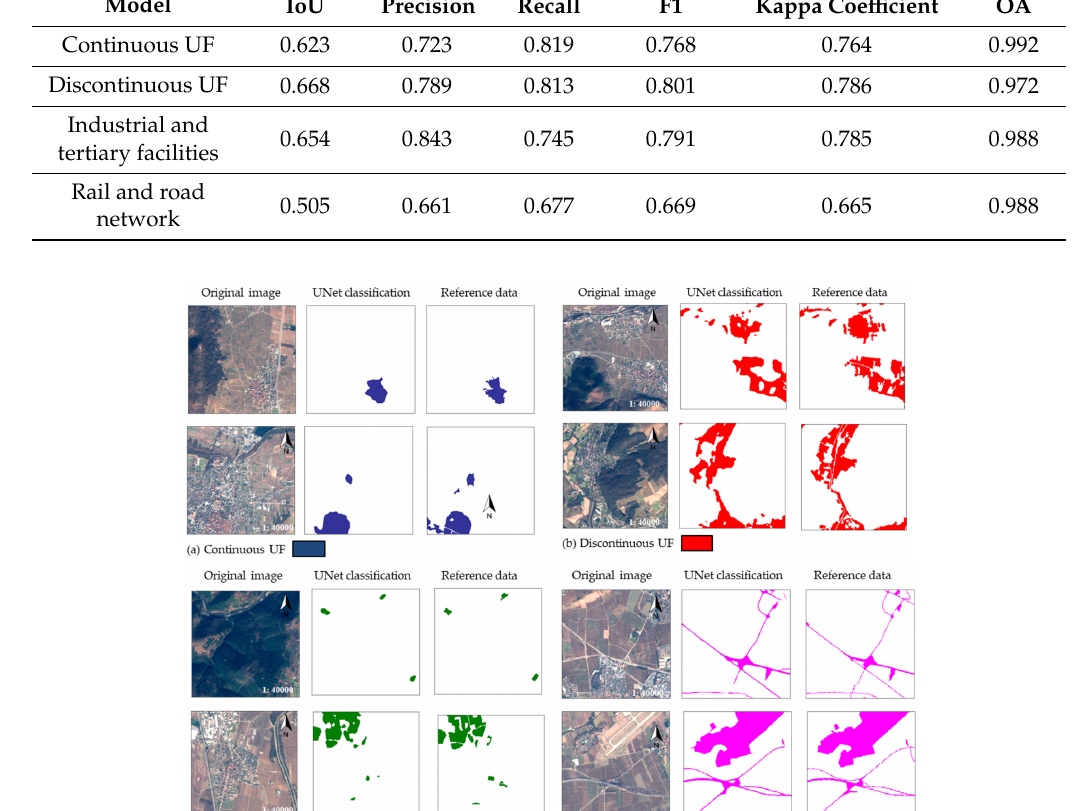
Figure 14. The computed F1 score for each sensing time per class. As we move away from the training dataset’s sensing period, the model’s performance gets worse. Moreover, the performance of discontinuous UF does not degrade as quickly as other classes. This can be explained by the number of available samples per class: a model trained over a large